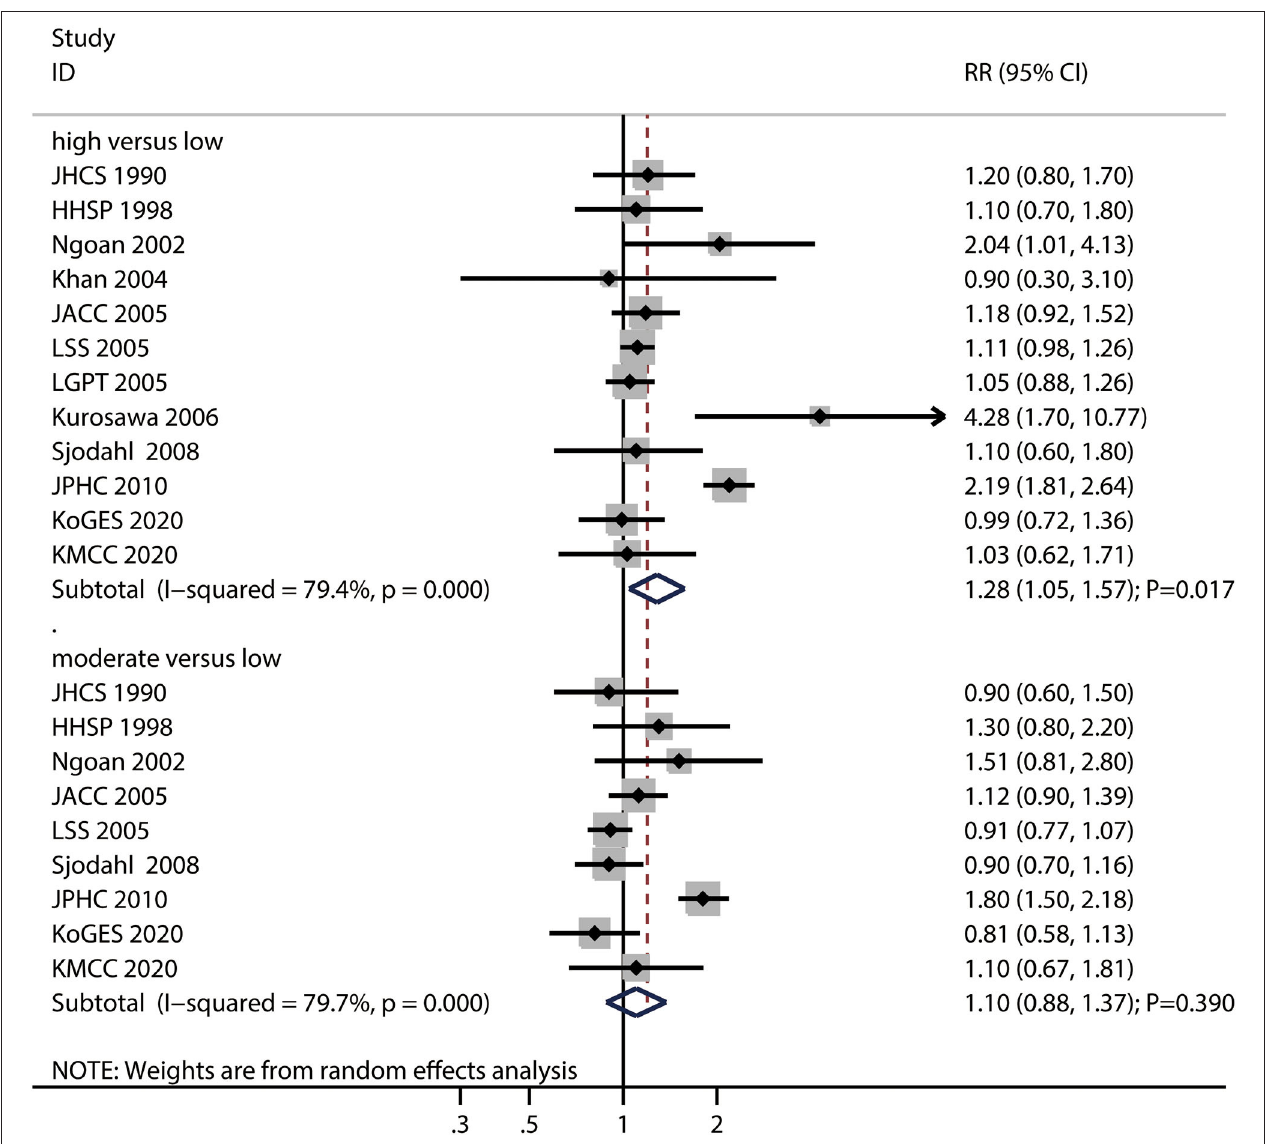
FIGURE 3 | Association between high or moderate pickled food intake and subsequent gastric cancer risk.